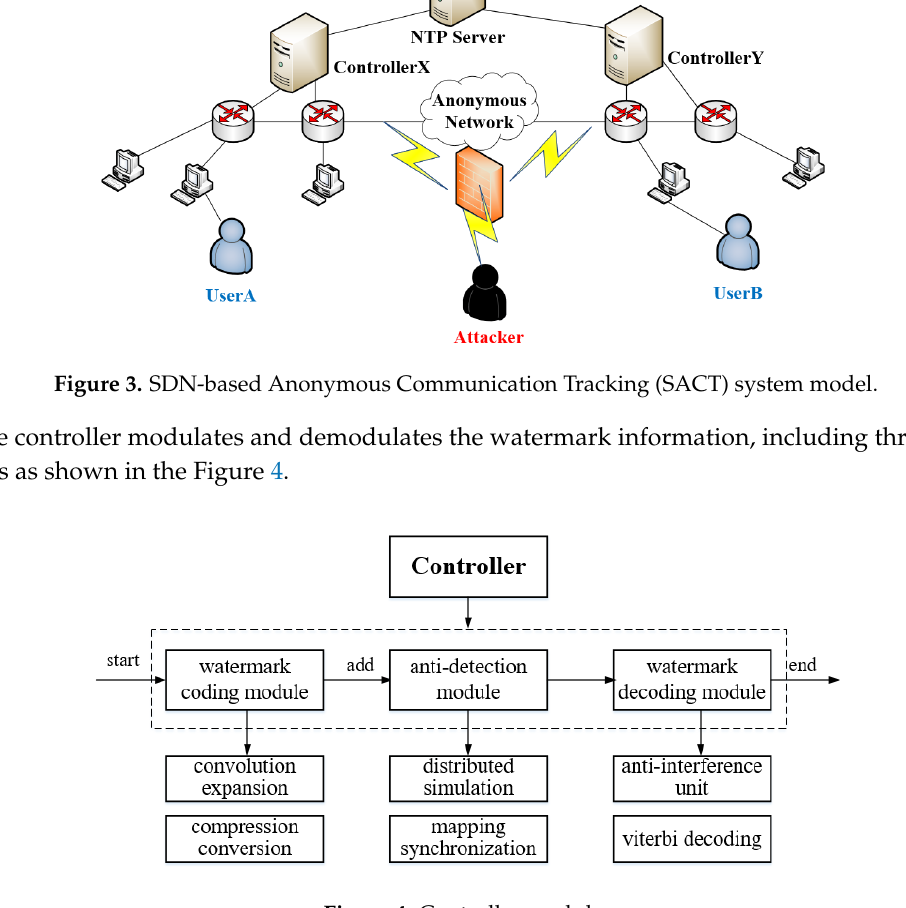
Figure 4. Controller